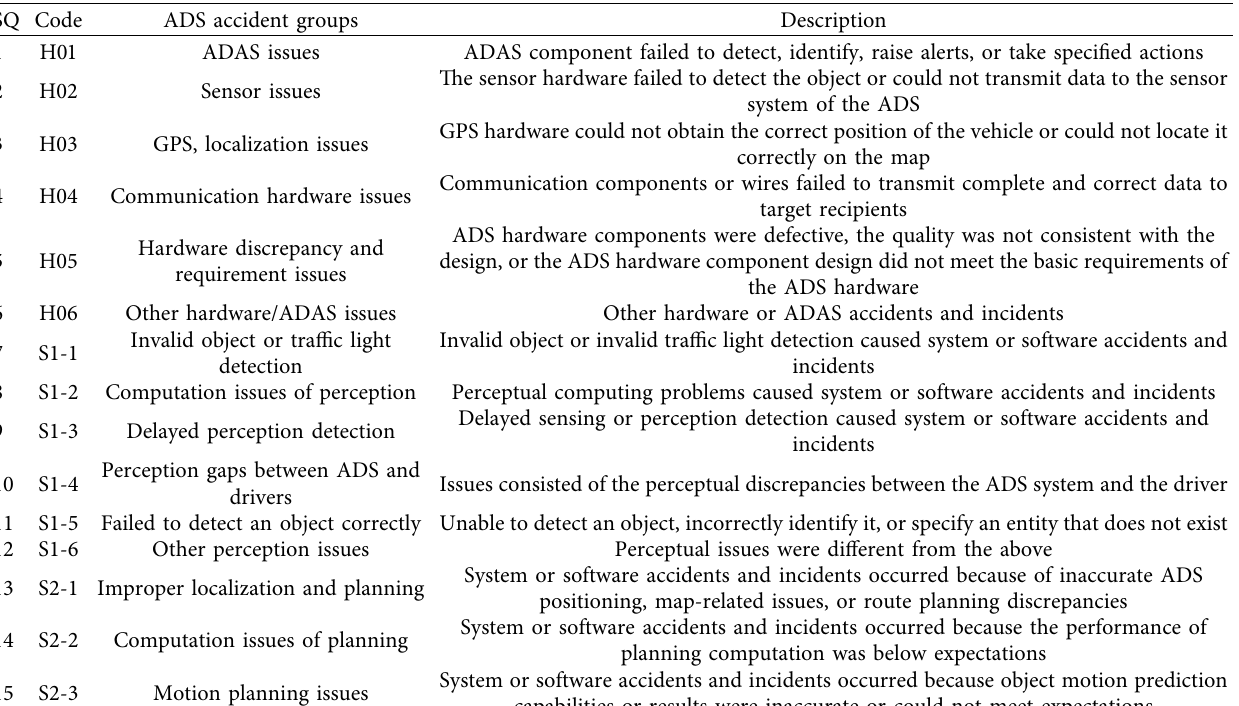
Table 2: Defnitions and descriptions of ADS accident